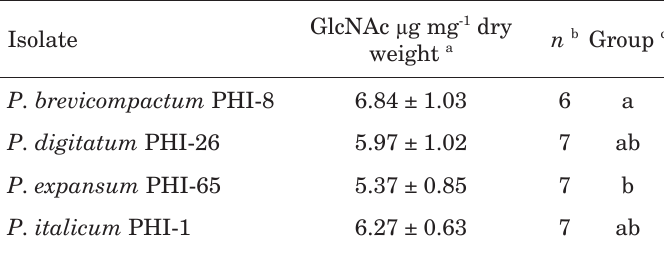
Table 1. Chitin content in mycelium of fungal